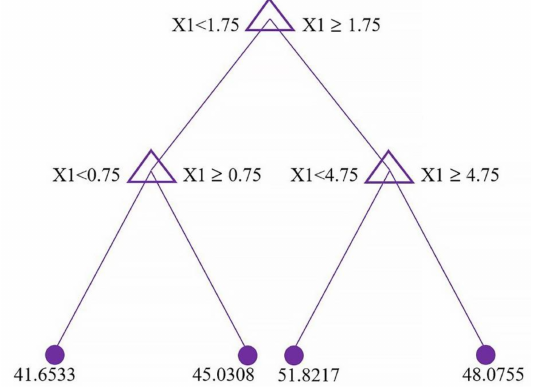
Figure 6. Visualization of the first trained regression tree.